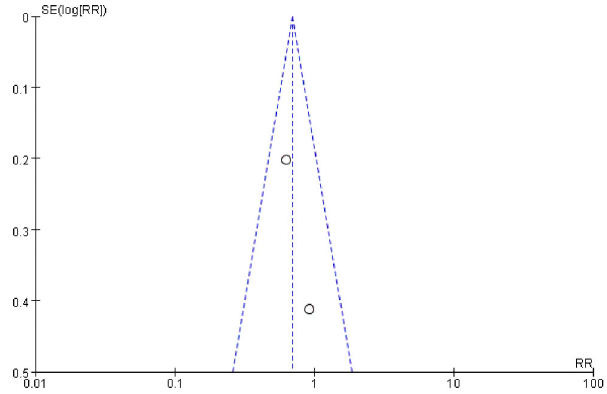
Figure 9. Funnel plot of trials of POST in PACU.